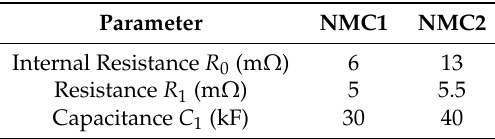
Table 2. Parameters of the equivalent circuit.